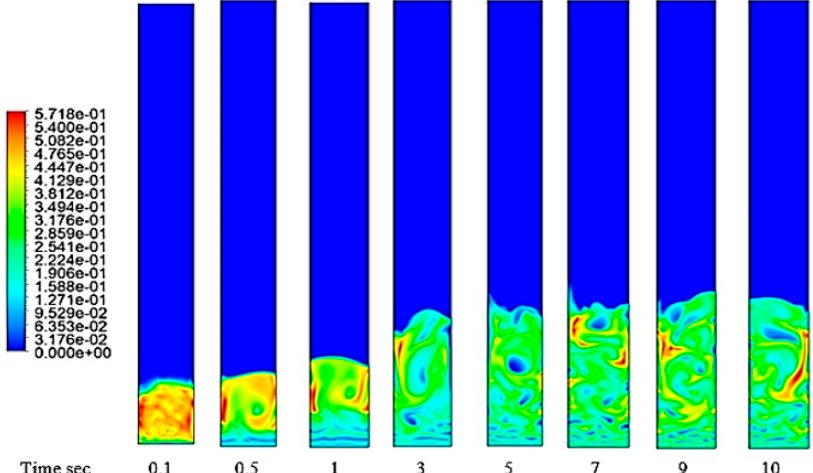
Figure 9. The volume fraction of particles with a diameter of 4 mm with different times.